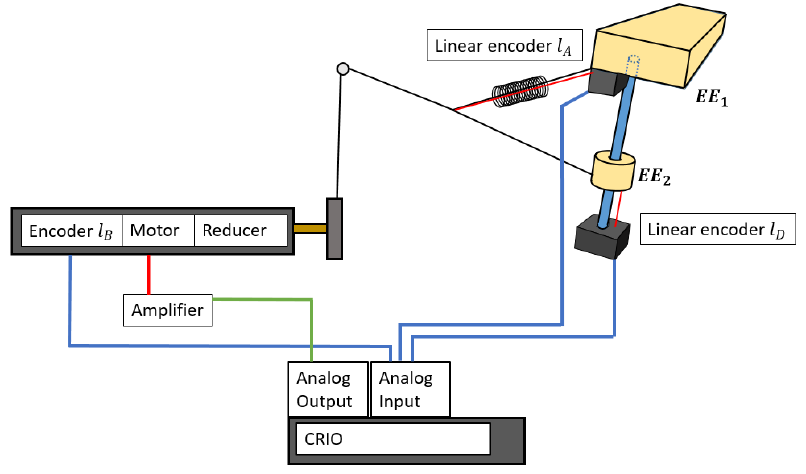
and while 𝑙𝑙 𝐴𝐴 𝑙𝑙 𝐷𝐷